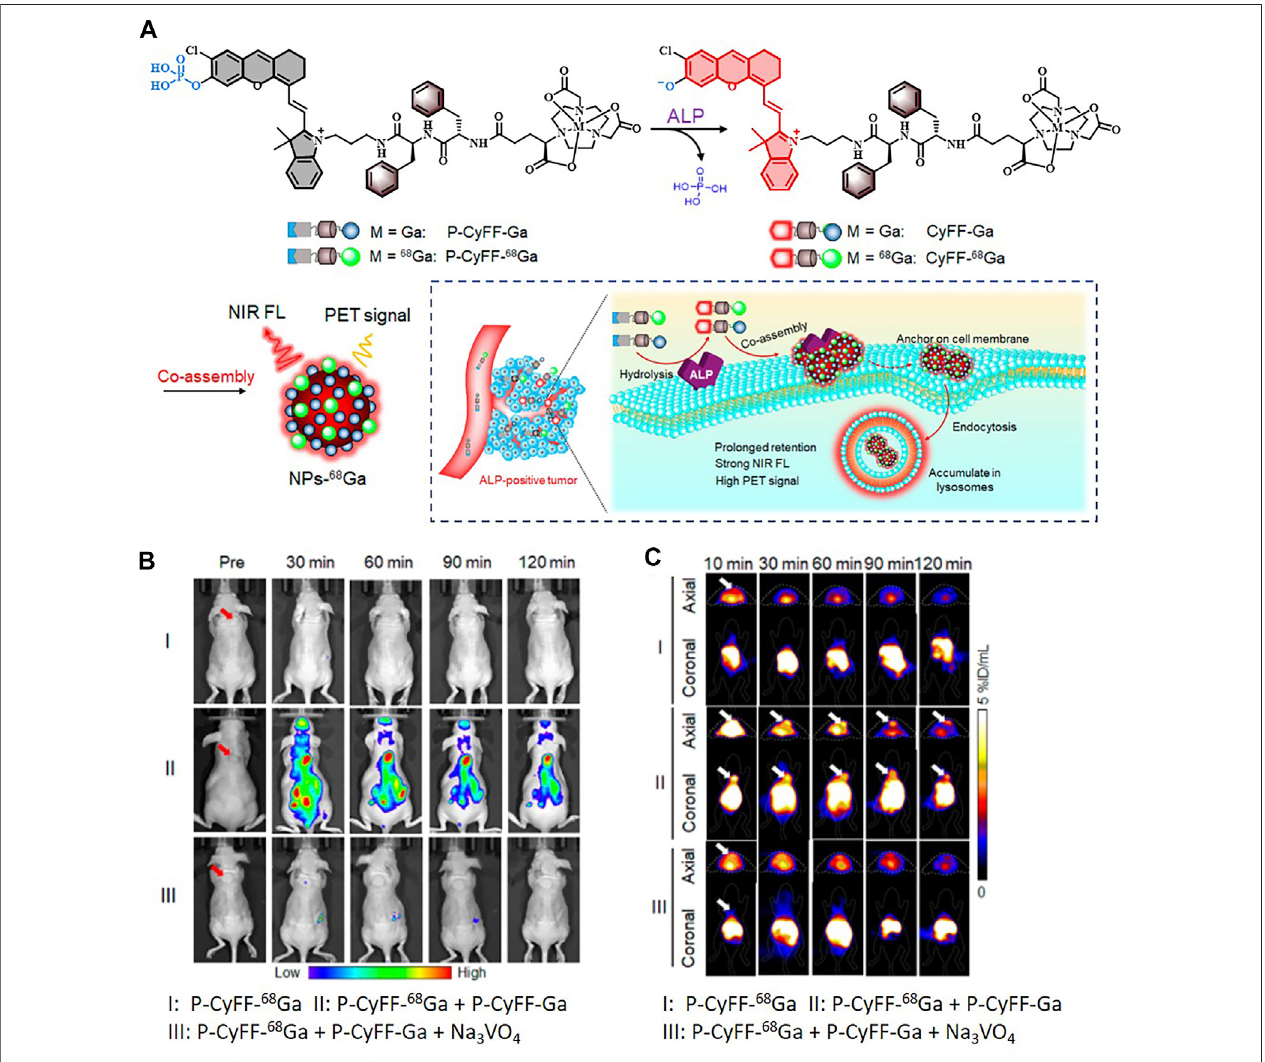
FIGURE 6 | (A) Schematic illustration showing an ALP-enabled in situ co-assembly strategy for FI/PET bimodal imaging. (B) Fluorescence images of HeLa tumor – bearing mice with different treatments. (C) PET imaging of HeLa tumor in mice at 10, 30, 60, 90, and 120 min postinjection of indicated substance. Reproduced with permission from Hu et al. (2021). Copyright 2021, American Chemical